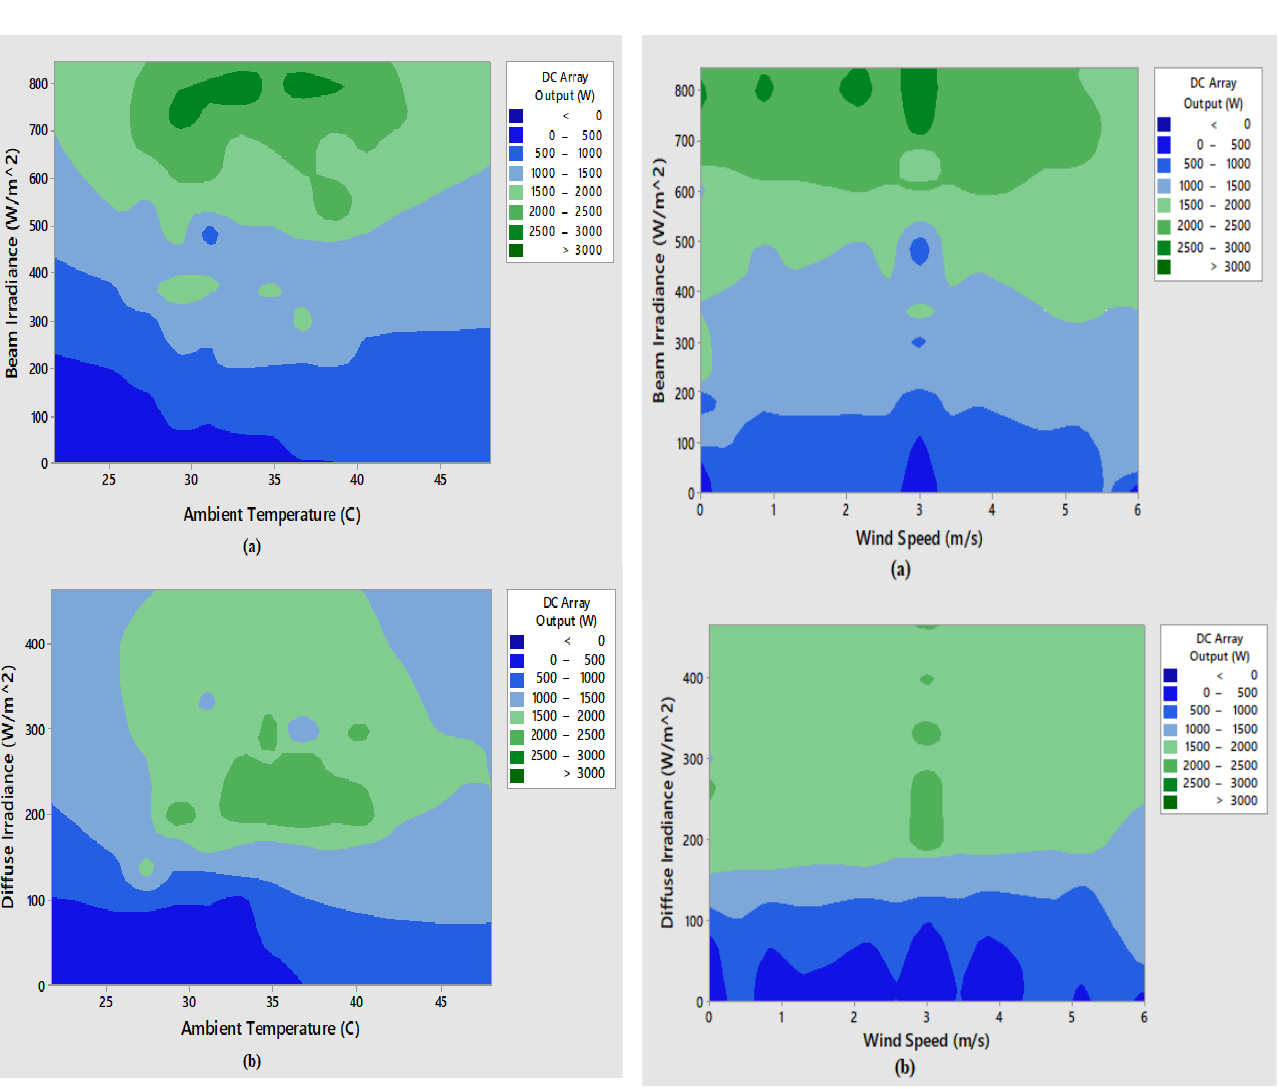
Figure 4. Effects on DC power output (a) influence of Beam Irradiance and Temperature, (b) influence of Diffuse Irradiance and Temperature.